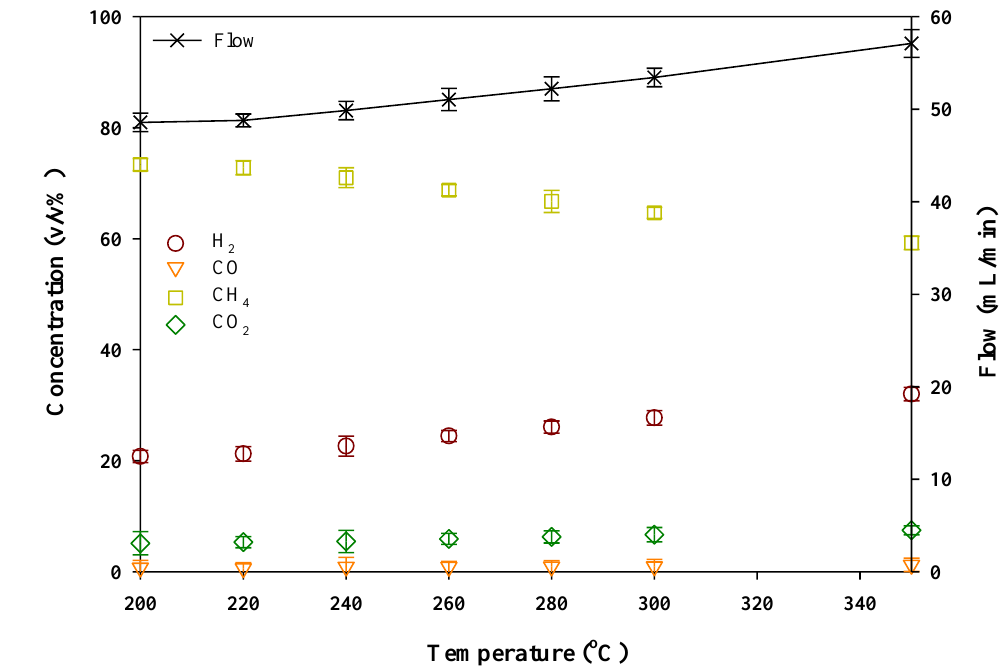
Figure 7. Result of COx methanation: At the ratio of inlet gases H 2 :CO 2 = 4:1 to H 2 :CO = 3:1.